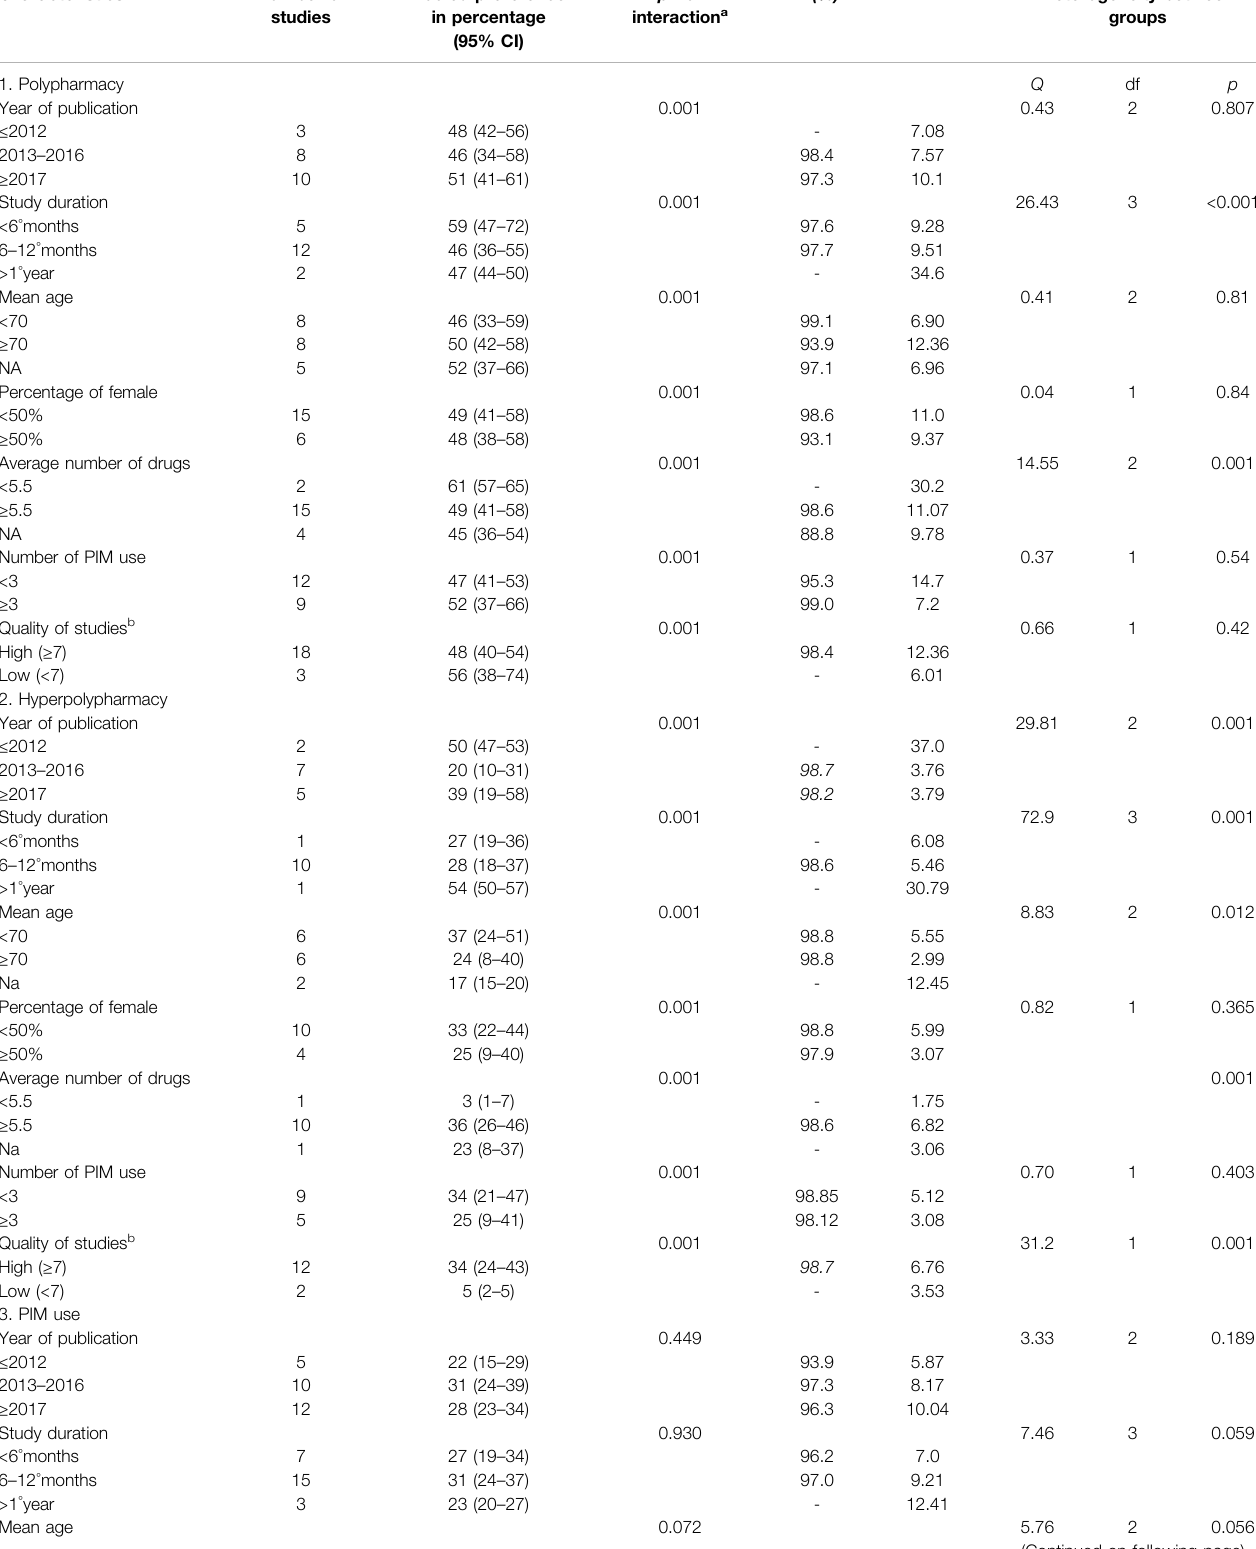
TABLE 2 | Strati fi ed meta-analysis of the prevalence of polypharmacy, hyperpolypharmacy, and potential inappropriate medication (PIM) use in India. Characteristics Number of